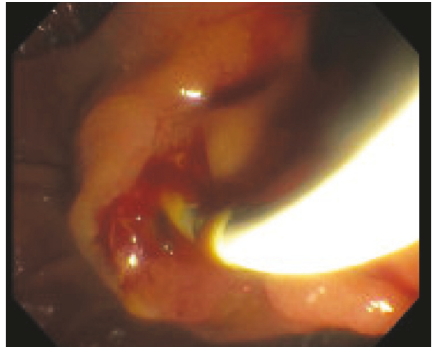
Figure 2: Blood clot being removed from ampulla during